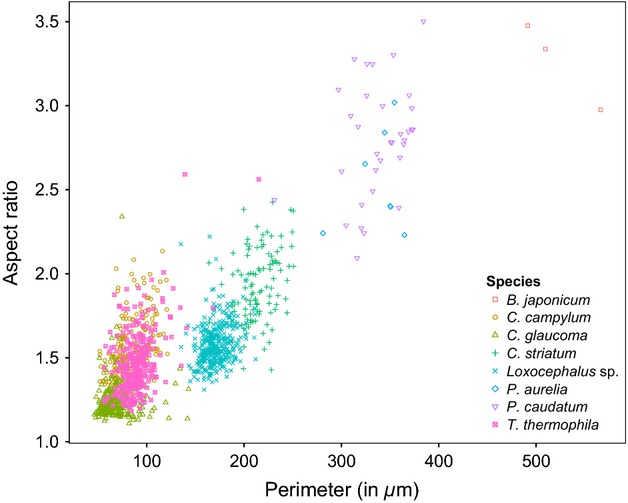
Morphological characteristics of eight ciliate species: cell perimeter and aspect ratio (major axis/minor axis of a fitted ellipse).